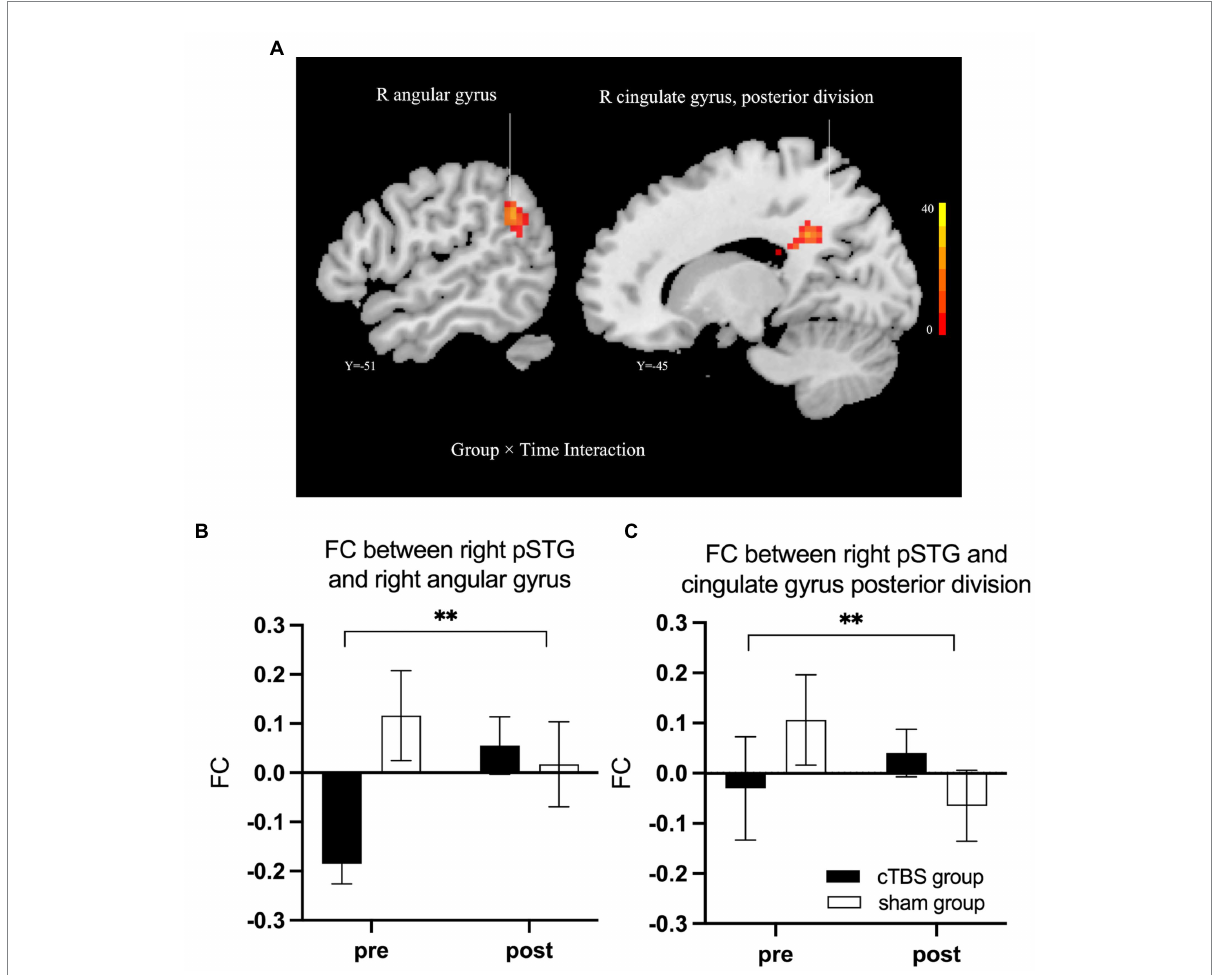
FIGURE 6 cTBS-induced changes in intrinsic functional connectivity (FC) of the right posterior superior temporal gyrus (pSTG) with the right angular gyrus and the posterior cingulate gyrus (A) . The cTBS group demonstrated increased FC of the right pSTG with the right angular gyrus and posterior cingulate gyrus after treatment; however, in the sham group, the FC between these areas was reduced after treatment. Bars show means, and error bars represent the standard error of the mean (SEM). We used a 2-factor mixed-effects ANOVA. ** indicates p < 0.001 in (B,C)